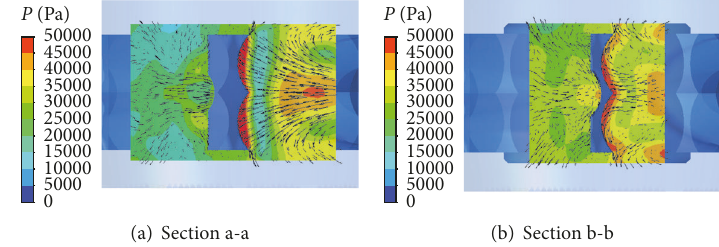
Figure 28: Static pressure distributions and absolute velocity vectors of Blade B ( 𝜃 ∗ = 36 ∘ , 𝑛 = 400 ,000 min −1 ).